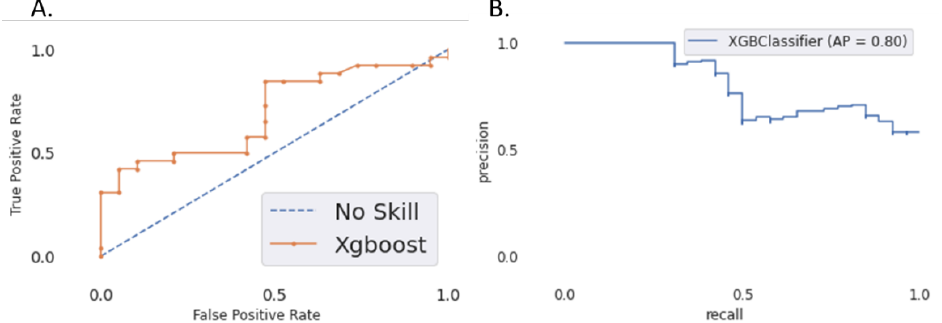
Figure 3. ( A ) ROC curve for the 18-month locoregional relapse prediction; ( B ) precision–recall curve on the test set (ART ORL).